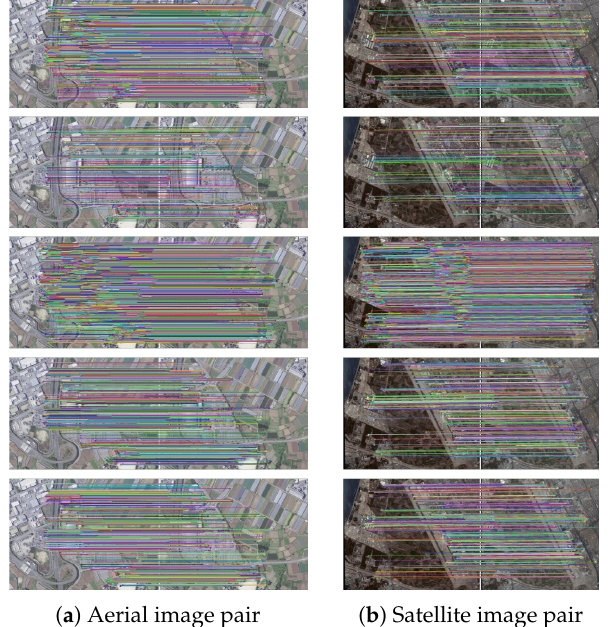
Figure 10. Image matching with using aerial and satellite image pairs (from top to bottom: EABRISK, SC-EABRISK, SC-EABRISK with ATBB, BEBLID, LATCH).